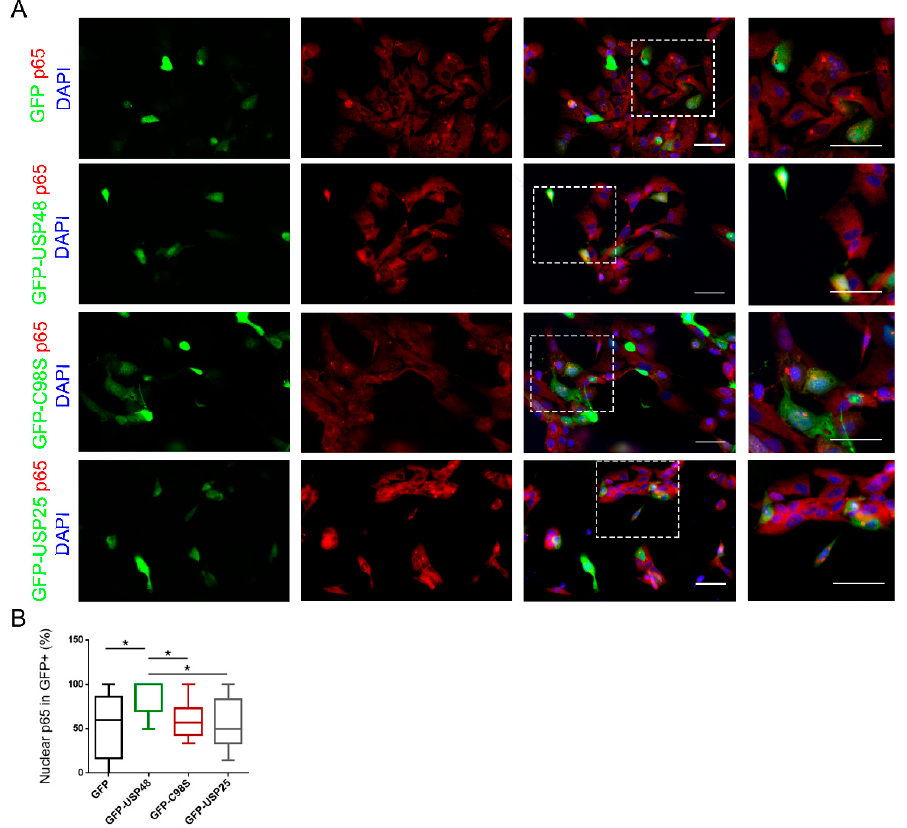
Figure 2. USP48 overexpression facilitates p65 nuclear localization. ( A ) Immunofluorescence images from hTERT-RPE1 transfected with either GFP (empty vector), GFP-USP48, GFP-USP48 C98S (catalytically inactive mutant), or unrelated GFP-USP25 (green), and immunostained with p65 (red). Nuclei were counterstained with DAPI (blue). Scale bar: 50 μ m in both lower and higher magnifi- cation images. ( B ) Quantification of the percentage of transfected cells presenting nuclear p65. The percentage of GFP-USP48 (WT) expressing cells showing p65 nuclear localization is increased in comparison with either GFP, GFP-USP48 C98S, or GFP-USP25. Box plots (min to max) were ob- tained from 11–17 images per condition from 2–3 independent replicates. Statistical analysis was performed by one-way ANOVA: * p -value ≥ 0.05.